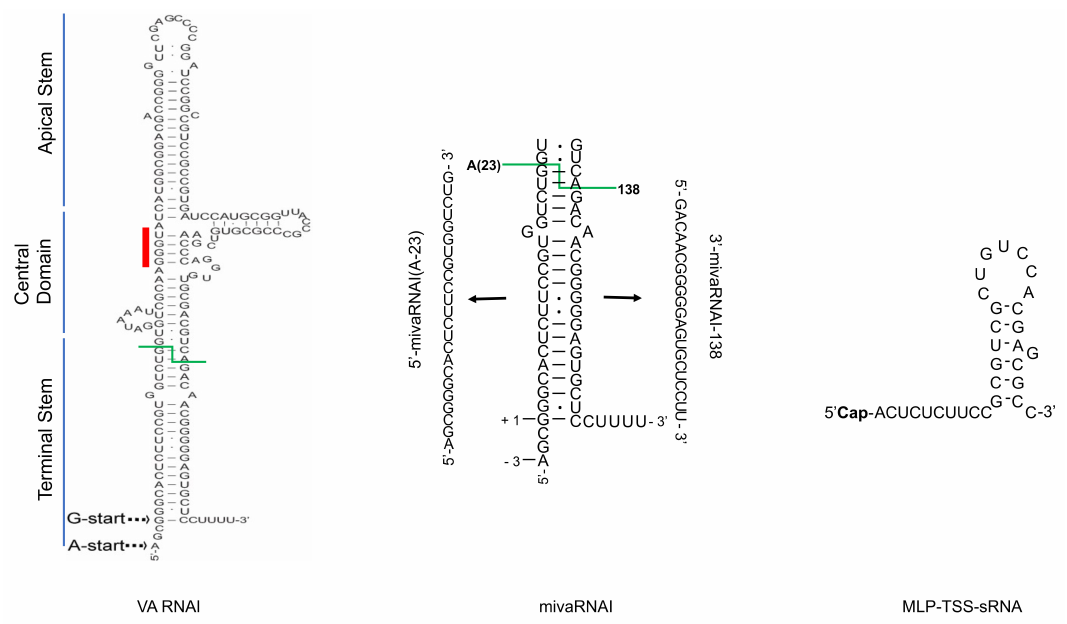
Figure 1. Structural overview of three Human adenovirus (HAdV) small non-coding RNAs (sncRNAs): virus-associated RNAI (VA RNAI), mivaRNAI and MLP-TSS-sRNA. The VA RNAI and mivaRNAI sequences are derived from HAdV-5 [22]. The MLP-TSS-sRNA sequence is from HAdV-37 [16]. Abbreviations: Cap; (m7G)-cap structure. Red line indicates the conserved tetranucleotide sequence (GGGU-ACCC), green line shows Dicer cleavage site within the terminal